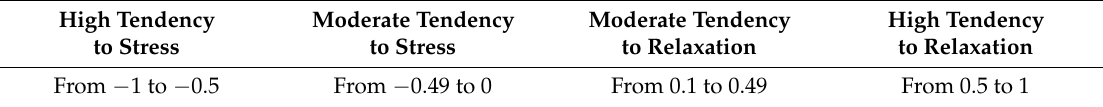
Table 1. Stress balance